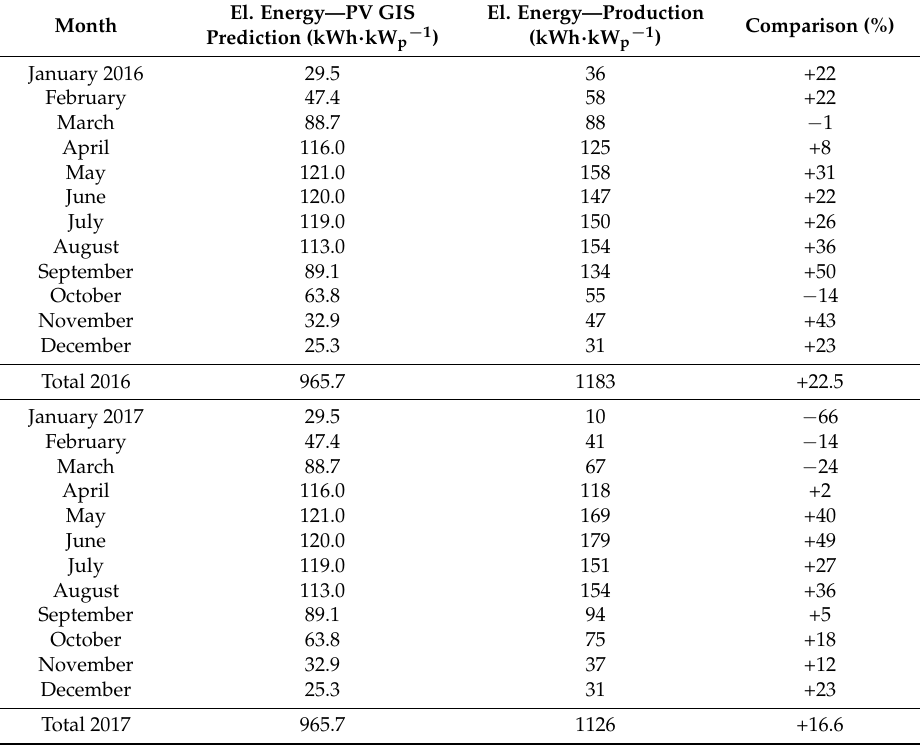
Table 1. Electric energy production during years 2016–2017—comparison of the measured values with the assumption according to PV